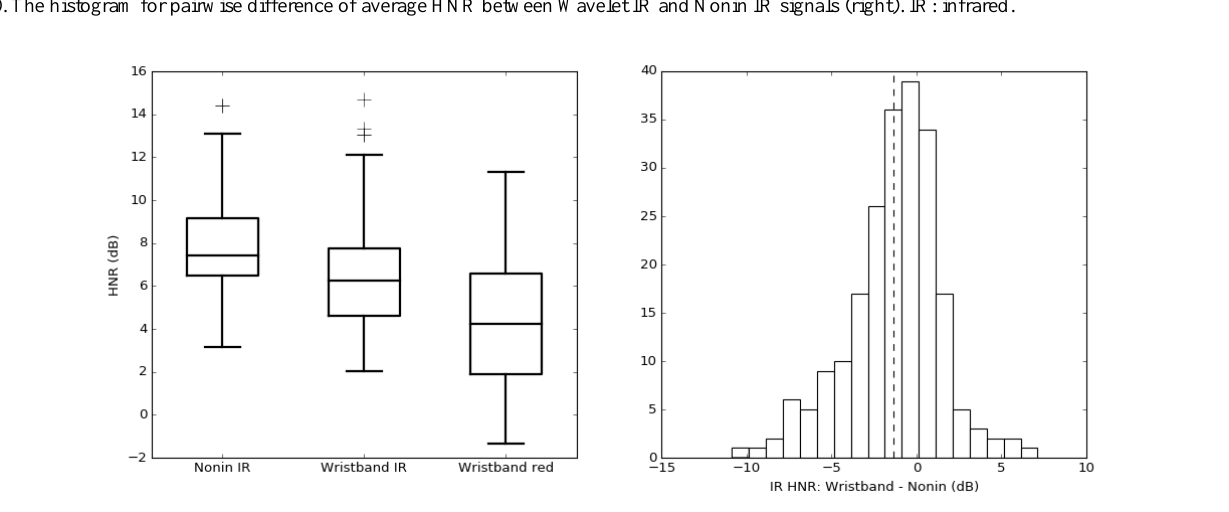
Figure 5. Boxplot comparison (left) of average harmonic-to-noise ratio (HNR) estimated over 60-second nonoverlapping windows for each photoplethysmography wavelength: Nonin finger-clip pulse oximeter (Nonin IR), the wristband infrared (Wavelet IR), and the wristband red (Wavelet red). The histogram for pairwise difference of average HNR between Wavelet IR and Nonin IR signals (right). IR: infrared.